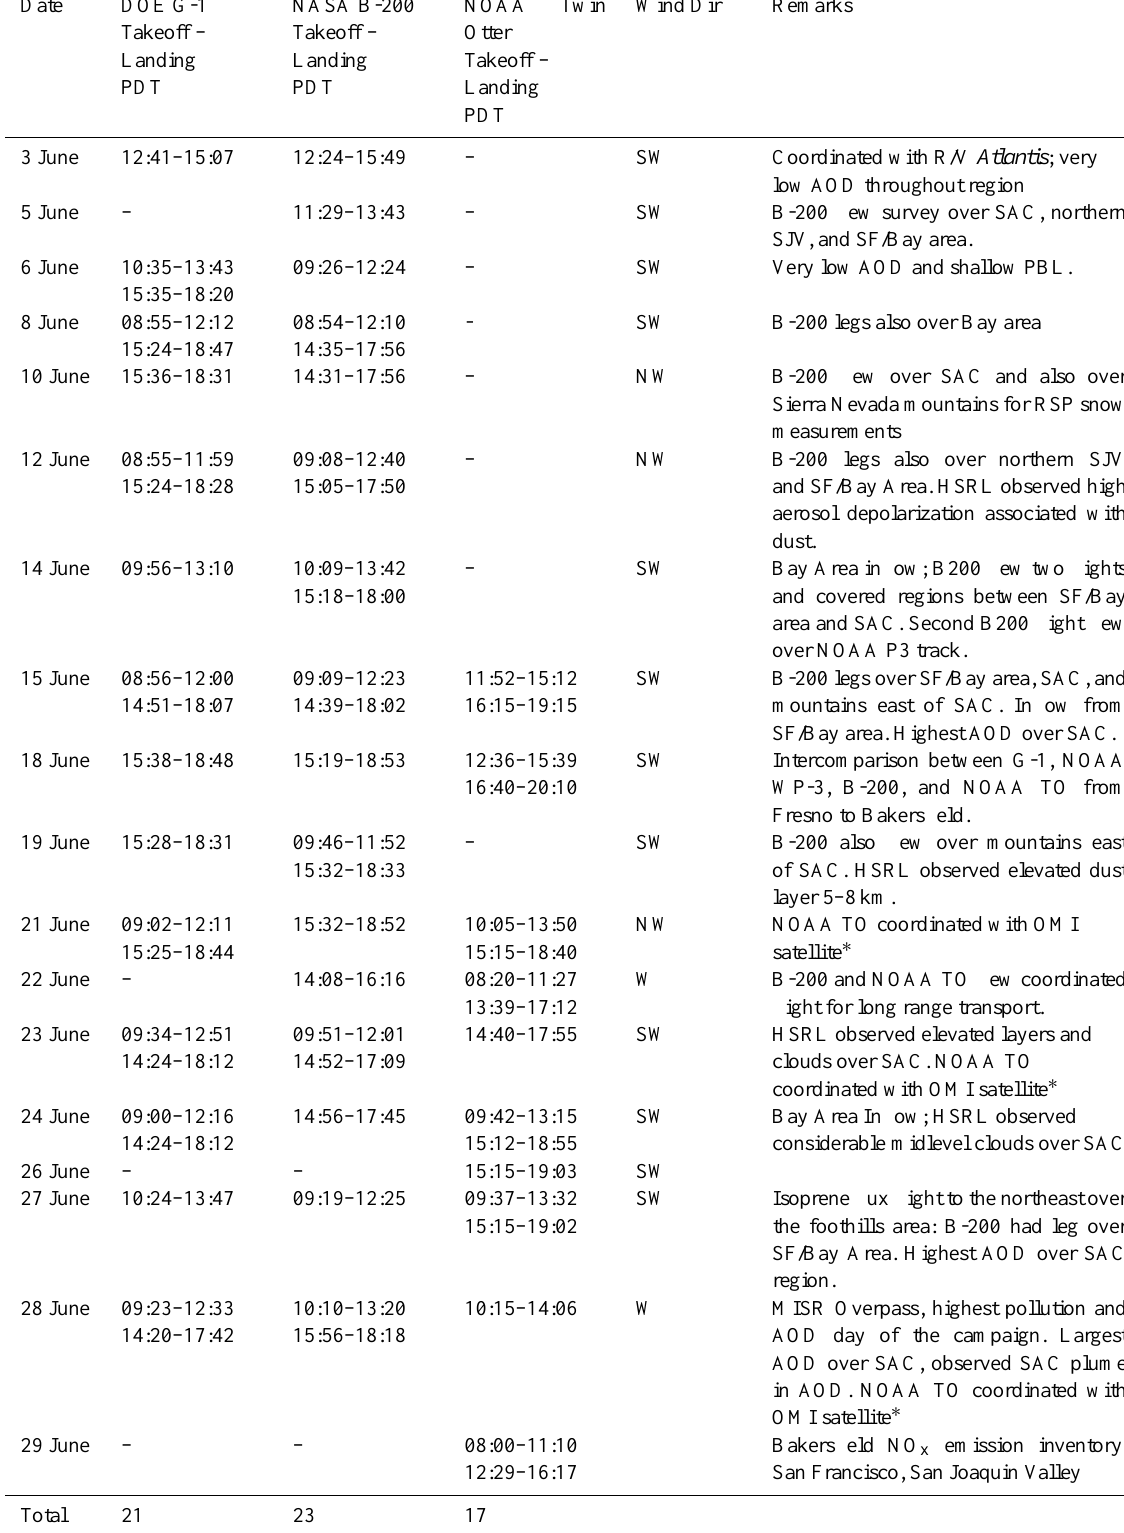
Table 5. Summary of DOE G-1, NASA-B200, and NOAA Twin Otter aircraft flights in the CARES domain during the month of June